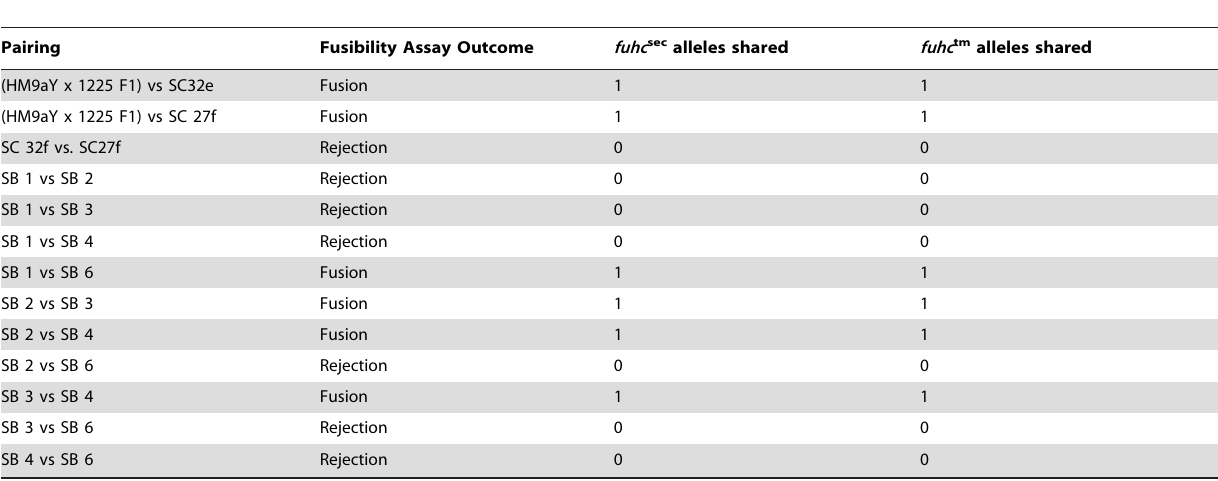
Table 2. fuhc sec and fuhc tm alleles correlate with fusion/rejection outcomes in wild-type individuals.